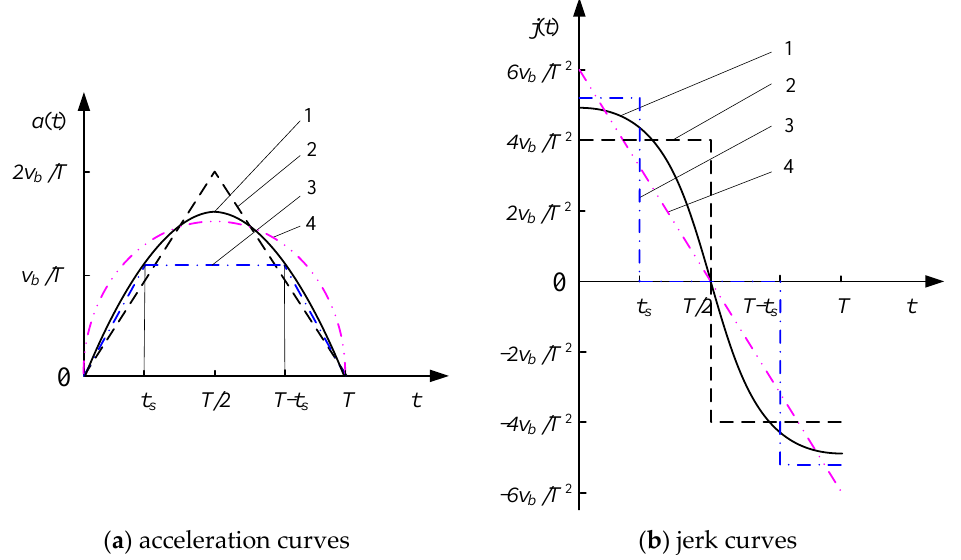
Figure 1. Comparisons of four soft-starting curves: 1-sine acceleration; 2-triangular acceleration; 3-trapezoidal acceleration; 4-parabolic acceleration.